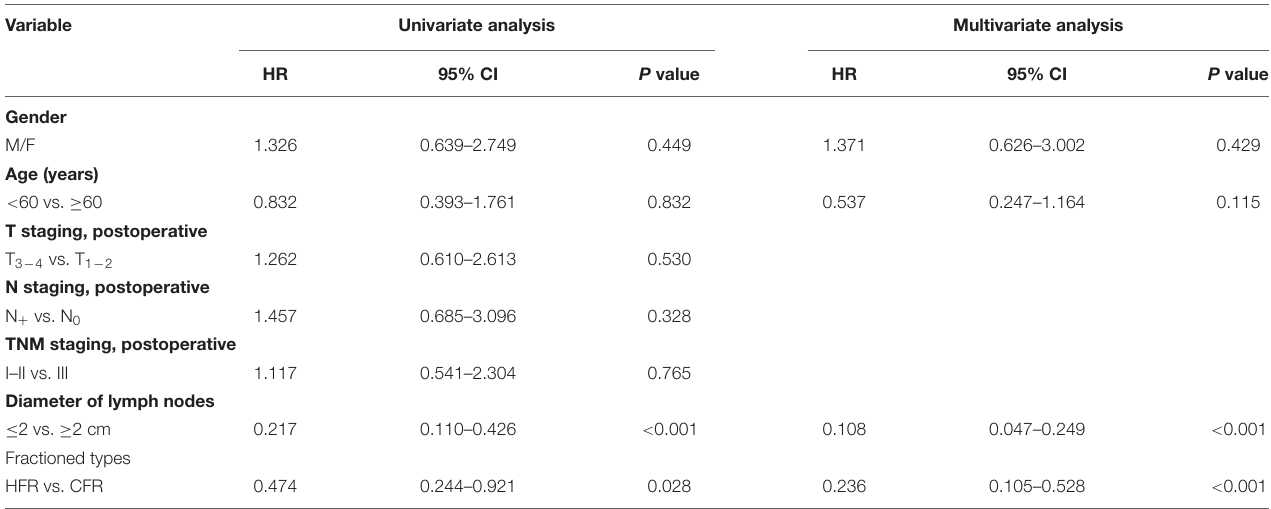
TABLE 5 | Univariate and multivariate analyses of OS covariants.